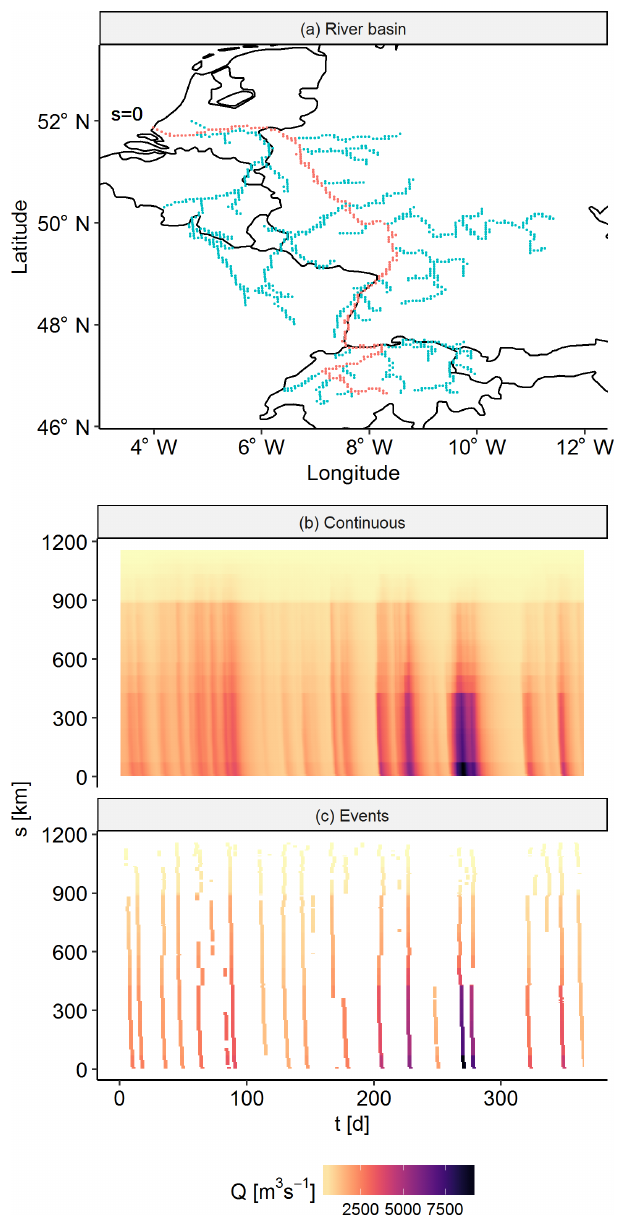
Figure 4. (a) A particular branch of the river Rhine. (b) The contin- uous discharge data on the river branch, where the river mouth is lo- cated at s = 0km and the head water is located around s = 1100km. (c) Events on the river branch. The polygons (i.e. separated islands of data) are discharge waves moving through the river